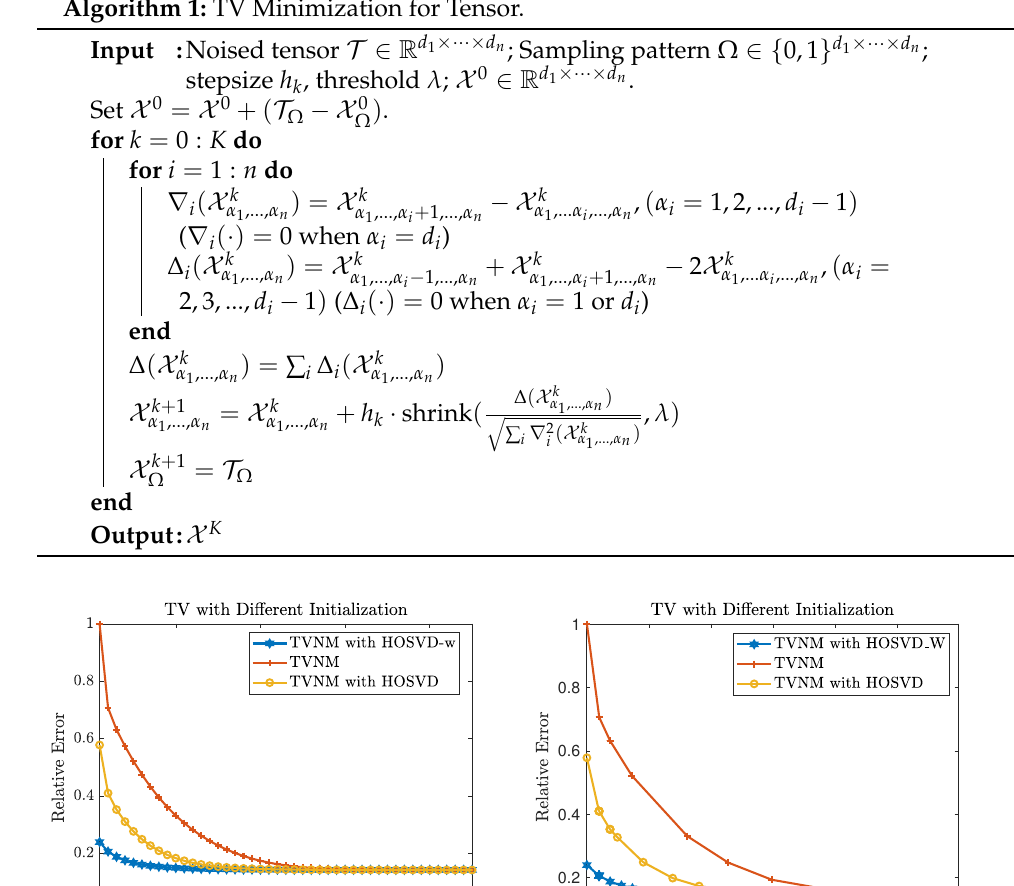
Algorithm 1: TV Minimization for Tensor.